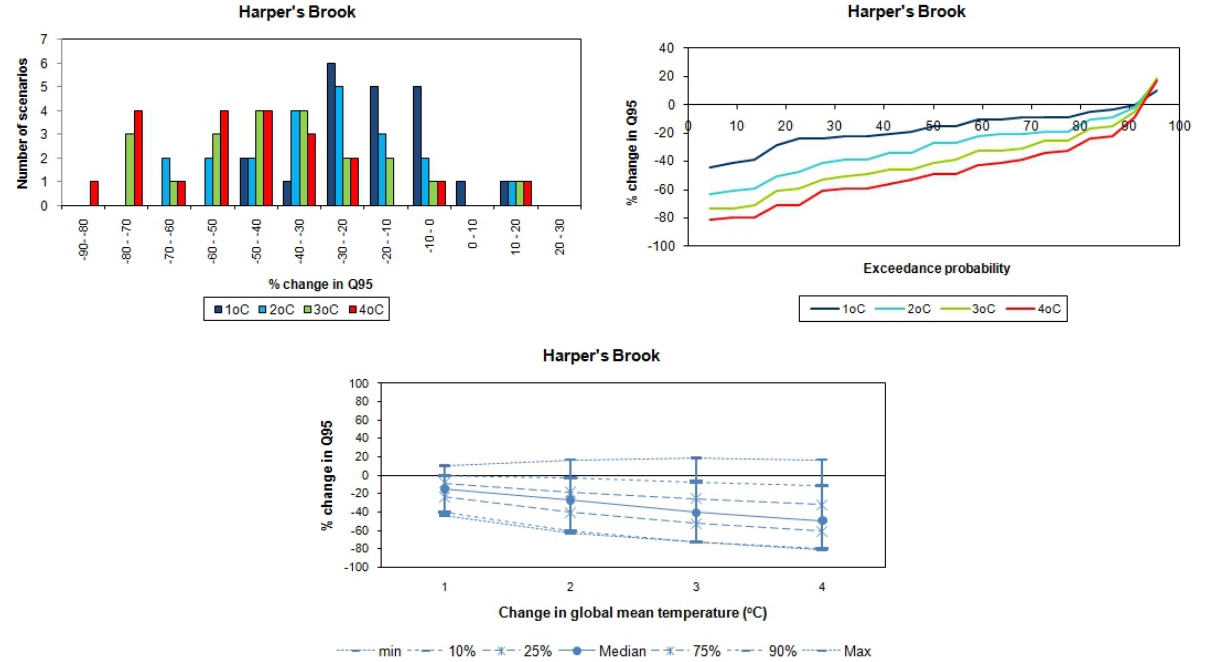
Fig. 9. Summary of the effects of climate model uncertainty on change in Q95 for the Harper’s Brook catchment, for 1, 2, 3 and 4 ◦ C rise in temperature. Top left: histograms of change. Top right: empirical distribution functions of change. Bottom left: quantiles from the empirical distribution